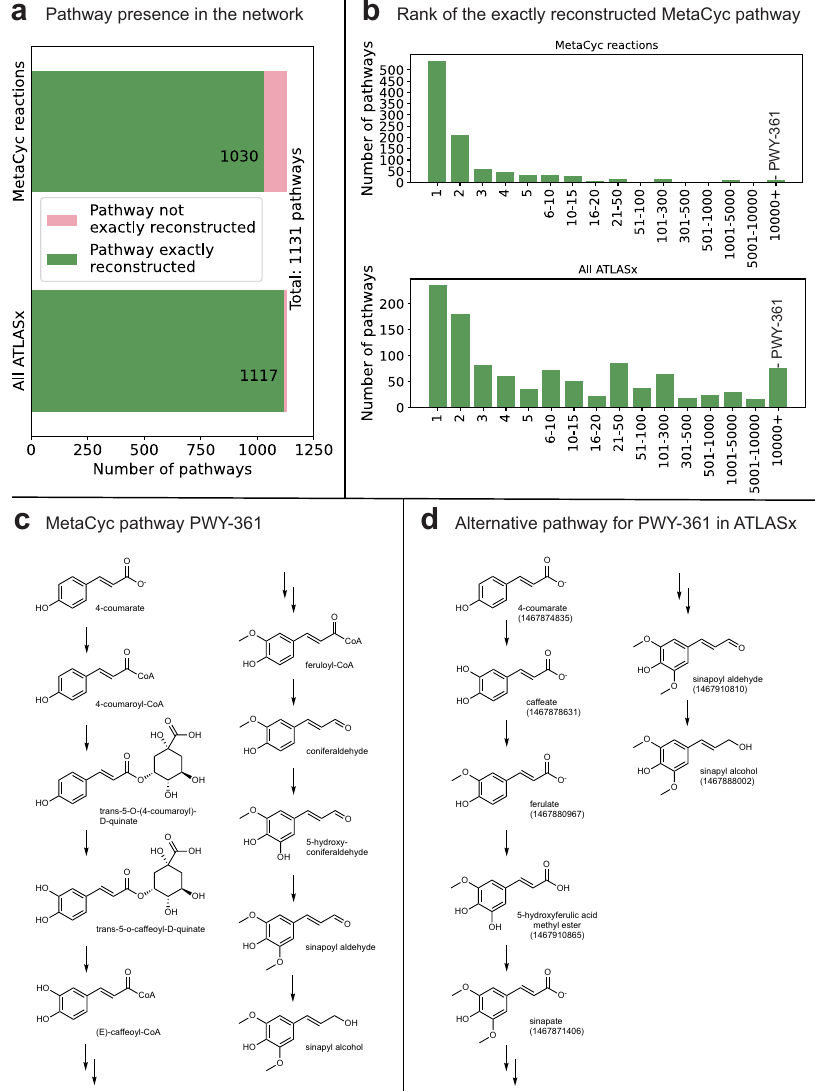
Fig. 3 Pathway search comparison to dataset of pathways extracted from MetaCyc. a Coverage of the collected MetaCyc pathways dataset (1131 pathways) with MetaCyc reactions in ATLAS and all ATLASx network. b Rank of the MetaCyc pathway according to the NICEpath pathway search algorithm. c For the MetaCyc pathway PWY-361 (phenylpropanoid biosynthesis) ATLASx found over 10,000 alternatives with better overall atom conservation. d Example of an alternative pathway for the original MetaCy pathway PWY-361. The LCSB IDs of the ATLASx compounds are given within